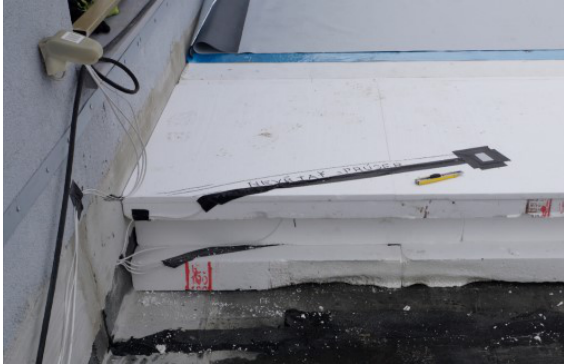
Figure 3. Incorporation the Sensirion SHT21 sensors during the reconstruction work.